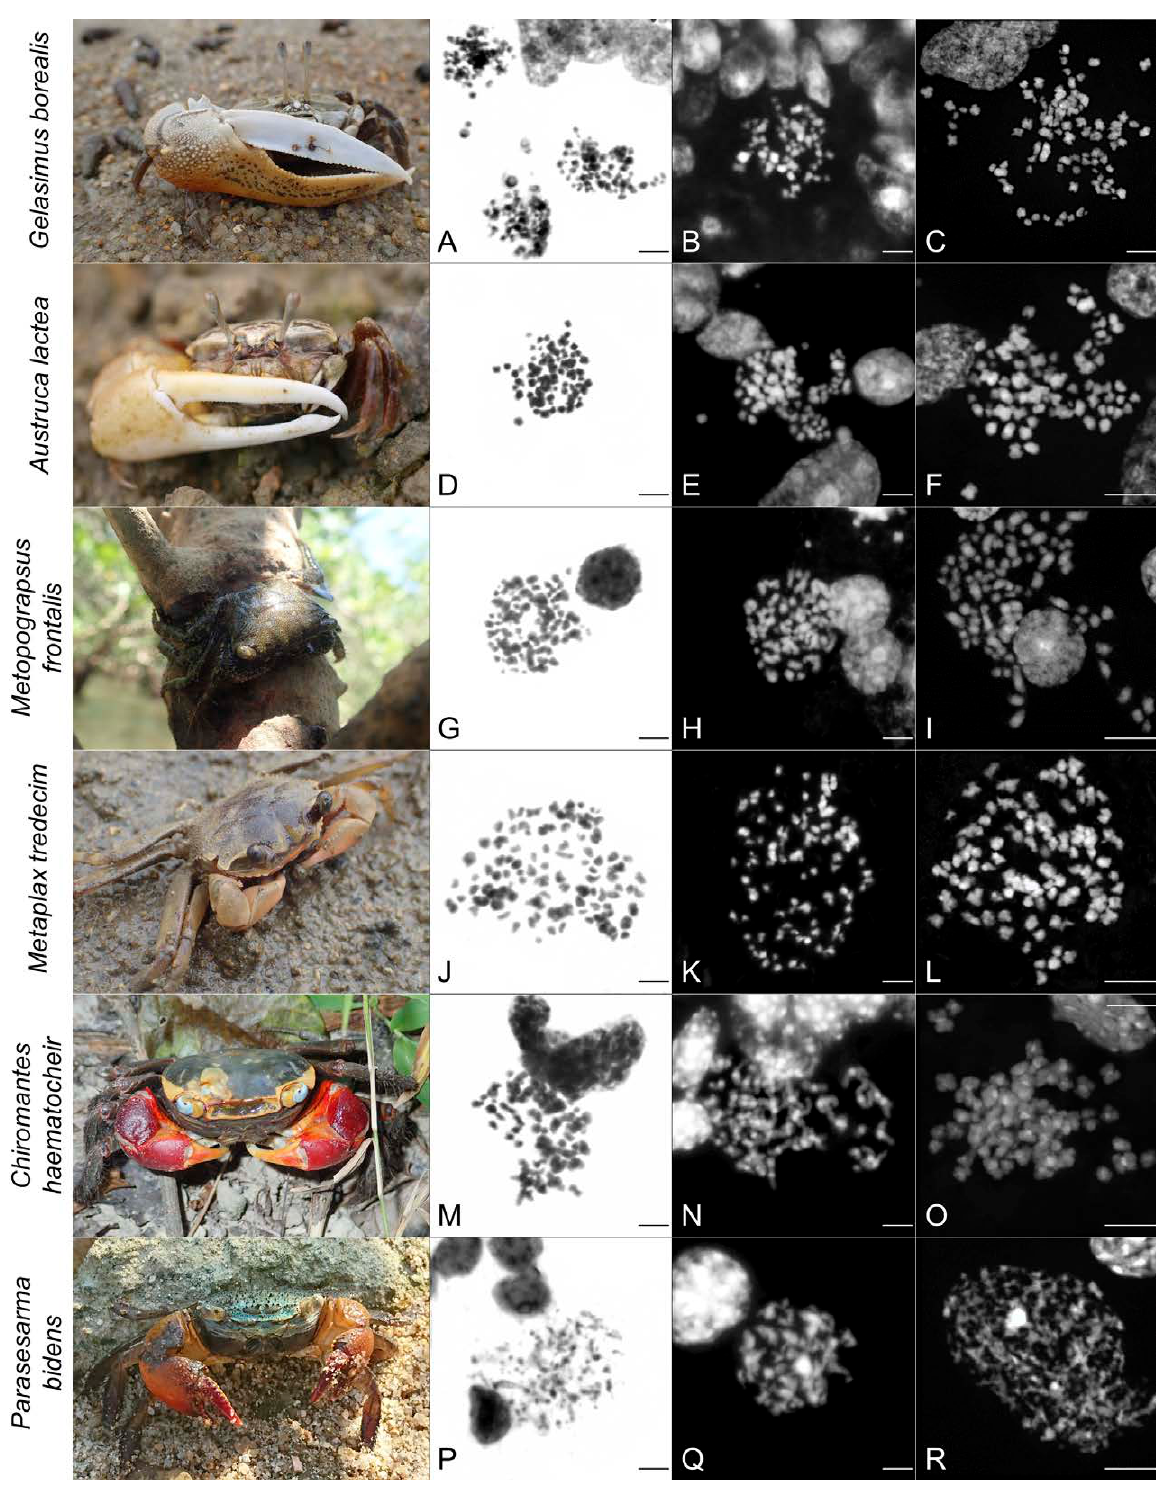
Figure 2. Metaphase spreads, obtained from eggs incubated with 0.05% colchicine and hypotonized with 0.075 M KCl of Gelasimus borealis ( A , B , C ) , Austruca lactea ( D , E , F ), Metopograpsus frontalis ( G , H , I ), Metaplax tredecim ( J , K , L ), Chiromantes haematocheir ( M , N , O ), Par- asesarma bidens ( P , Q , R ). Slides were either stained with Giemsa and observed under an optical microscope ( A , D , G , J , M , P ) or stained with DAPI and observed under a fluorescent ( B , E , H , K , N , Q ) and confocal microscope ( C , F , I , L , O , R ). Photos by Stefano